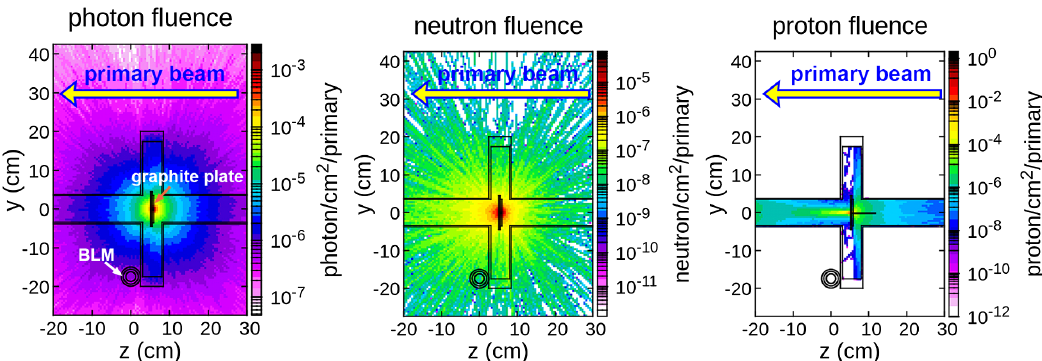
FIG. 15. The photon (left), neutron (middle), and proton (right) fluence distribution in the vicinity of the YZ plane (averaged over 1 cm) for beam loss on the emittance monitor.